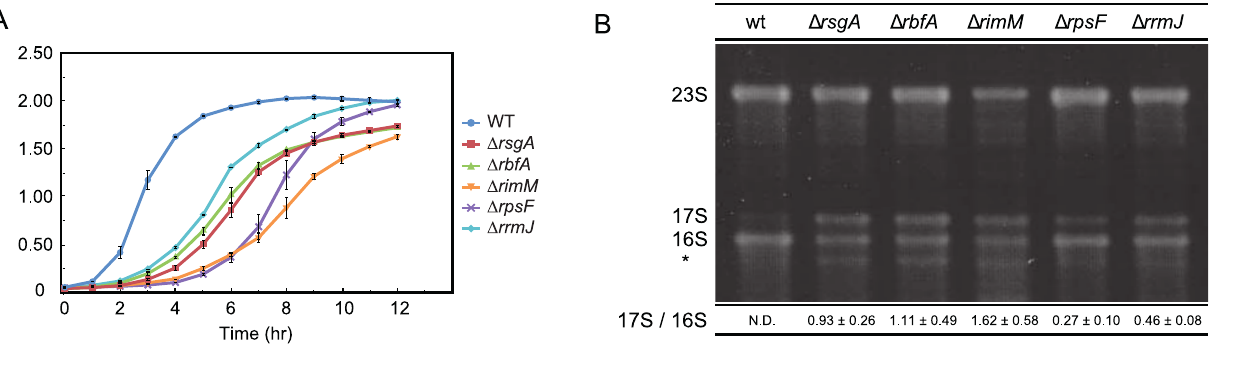
Figure 1. Properties of mutant cells and effect of salt shock on cell growth. (A) Growth of E. coli mutant cells under normal culture conditions. Growth of wild-type, n rsgA , n rbfA , n rimM , n rpsF or n rrmJ cells at 37 u C in LB medium was monitored by measuring OD 600 . (B) Accumulation of 17S RNA in mutant cells. One m g of total RNA fraction prepared from each of the cells was electrophoresed on 1.8% agarose gel. The 3 9 truncation product of 16S rRNA is indicated by an asterisk [11]. The band of slightly lower migration than that of 16S rRNA was confirmed as 17S RNA by northern hybridization (Figure S1). The ratio of the amount of 17S RNA to that of 16S rRNA is shown below each lane. (C) Defect in subunit assembly of ribosome in mutant cells. Cells were lysed with alumina powder and the cell debris was removed as described in Materials and Methods. Ten A 260 units of crude cell extracts were fractionated by 5%–20% sucrose density gradient ultracentrifugation. (D) Growth curves of mutant cells